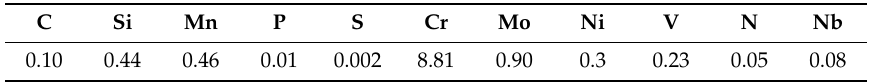
Table 1. Chemical composition of the P91 steel according to the material’s certificate (wt.%). C